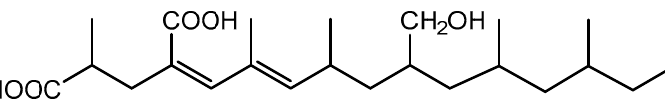
Figure 4. Structure of the compound F99-909A.